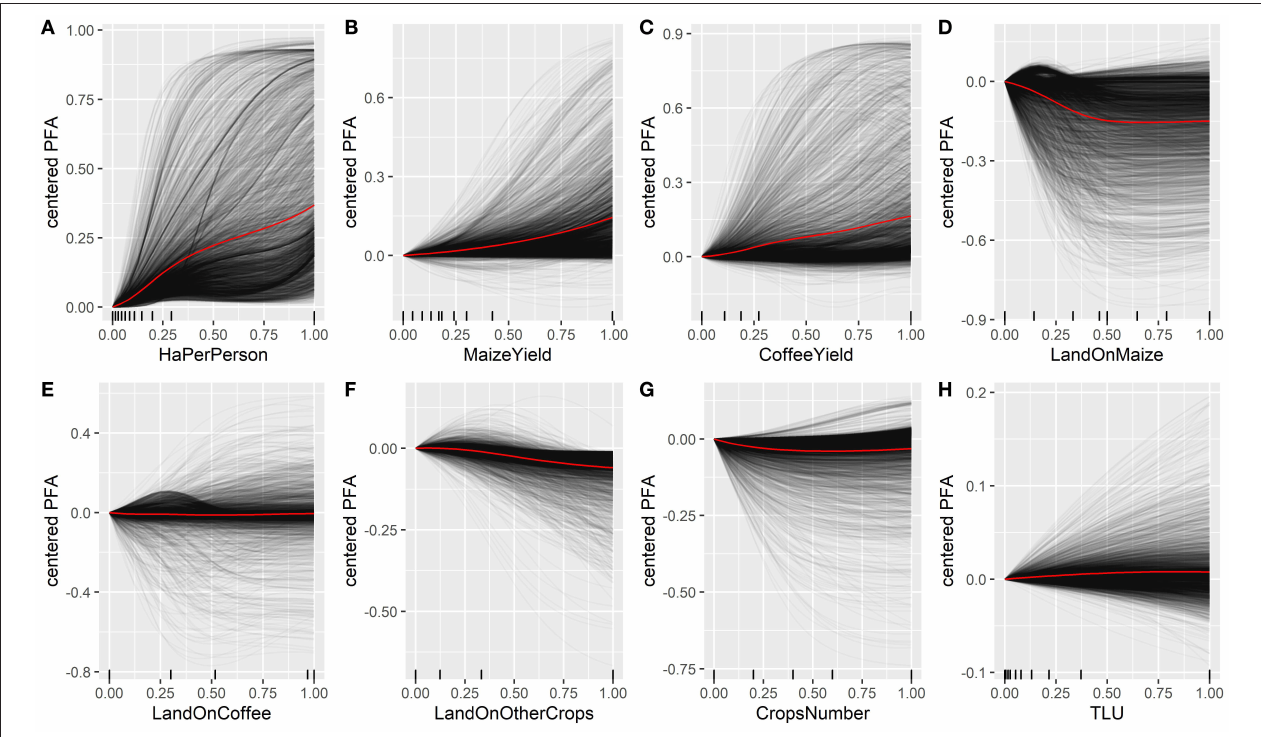
FIGURE 5 | Individual conditional expectation plots (ICEplots) for variables (A) hectares per person, (B) maize yield, (C) coffee yield, (D) land on maize, (E) land on coffee, (F) land on other crops, (G) crops number, (H) tropical livestock units. The x axis is scaled to 0–1, and the y -axis is scaled and centered in 0. The red line represents the partial dependency plot (average). Each curve in gray shows the projection of each sample along the predictor’s variation